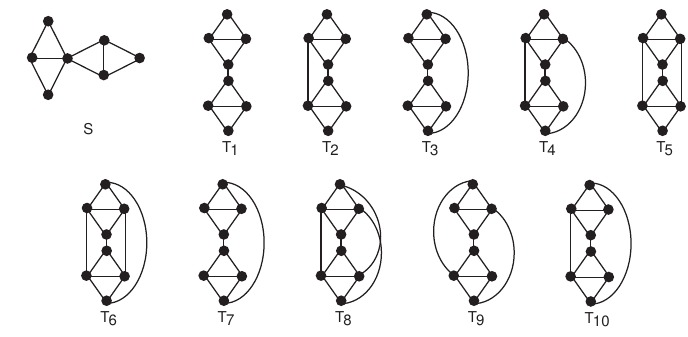
Fig. 2: Some forbidden induced subgraphs for probe diamond-free graphs.